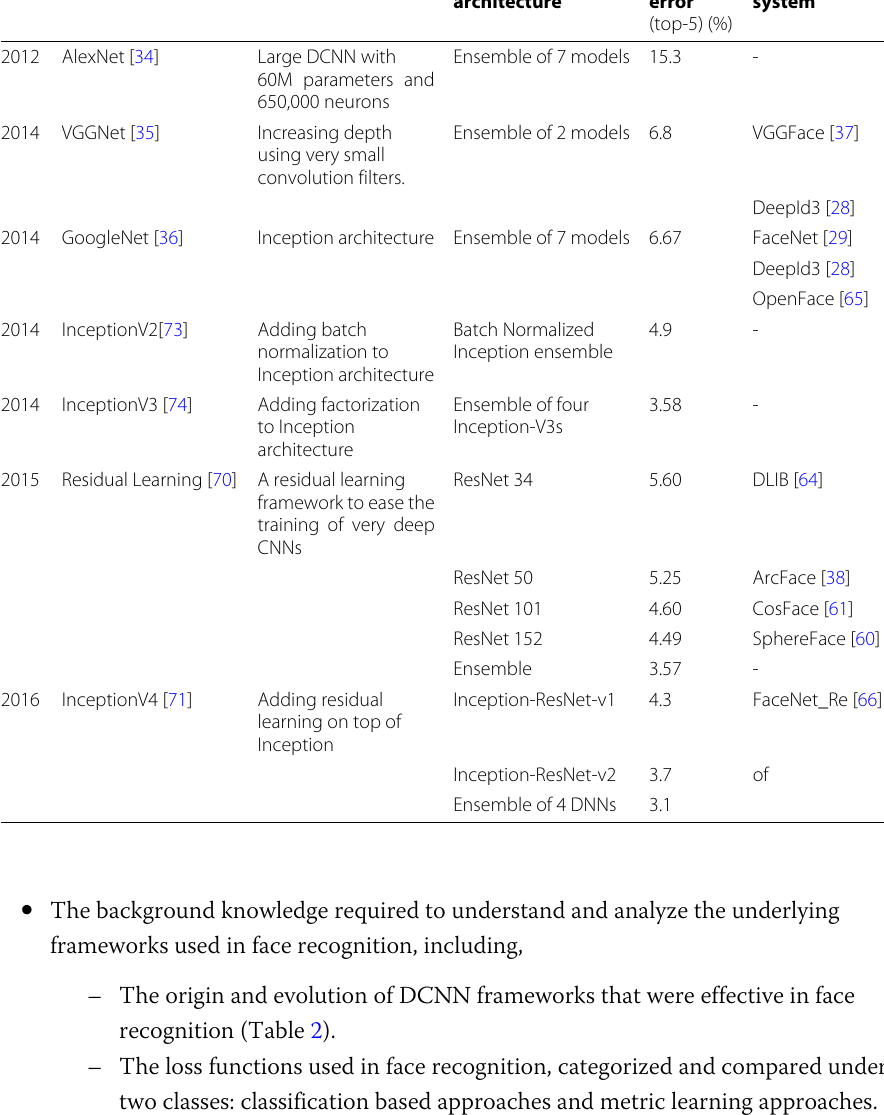
Table 2 DCNN frameworks that had significant impact on face recognition Year